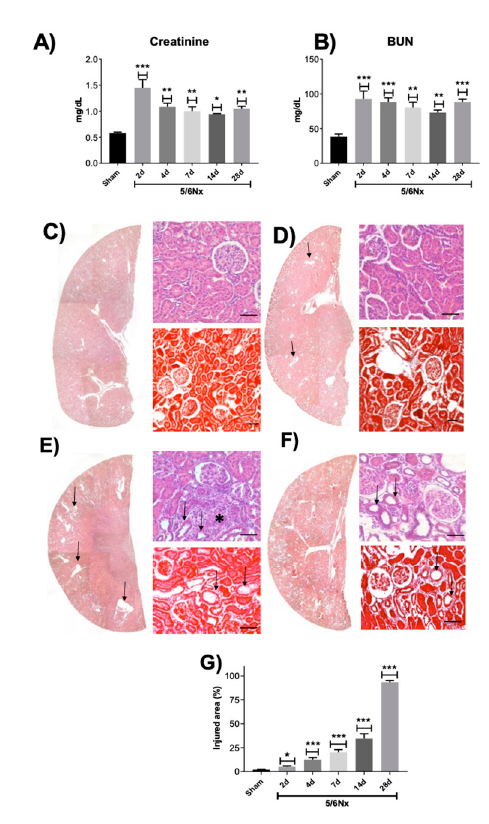
Figure 1. Markers of renal function of the experimental groups. ( A ) Creatinine and ( B ) blood urea nitrogen (BUN) in plasma. ( C – F ) Representative micrographs of kidney from different time points, low power (left panel), hematoxylin/eosin (H&E, right upper figure), and Masson trichrome staining (right bottom figure). ( C ) Normal kidney histology from Sham animal. ( D ) On day 7 of 5/6 nephrectomy (5/Nx), there are focal areas of tubular atrophy (black arrows). ( E ) Three weeks after nephrectomy, there were more and bigger areas of tubular atrophy (black arrows) and mild interstitial inflammatory infiltrate (asterisk). ( F ) After four weeks of nephrectomy, extensive areas of the kidney were affected showing tubular epithelium atrophy (black arrows), interstitial inflammation with mild fibrosis. ( G ) The automated morphometry measurement showed progressive areas of kidney injury. Data are mean ± SEM, n = 4. * p < 0.05, ** p < 0.01, *** p < 0.001 vs. Sham, Dunnett test. Scale bar = 100 µ.